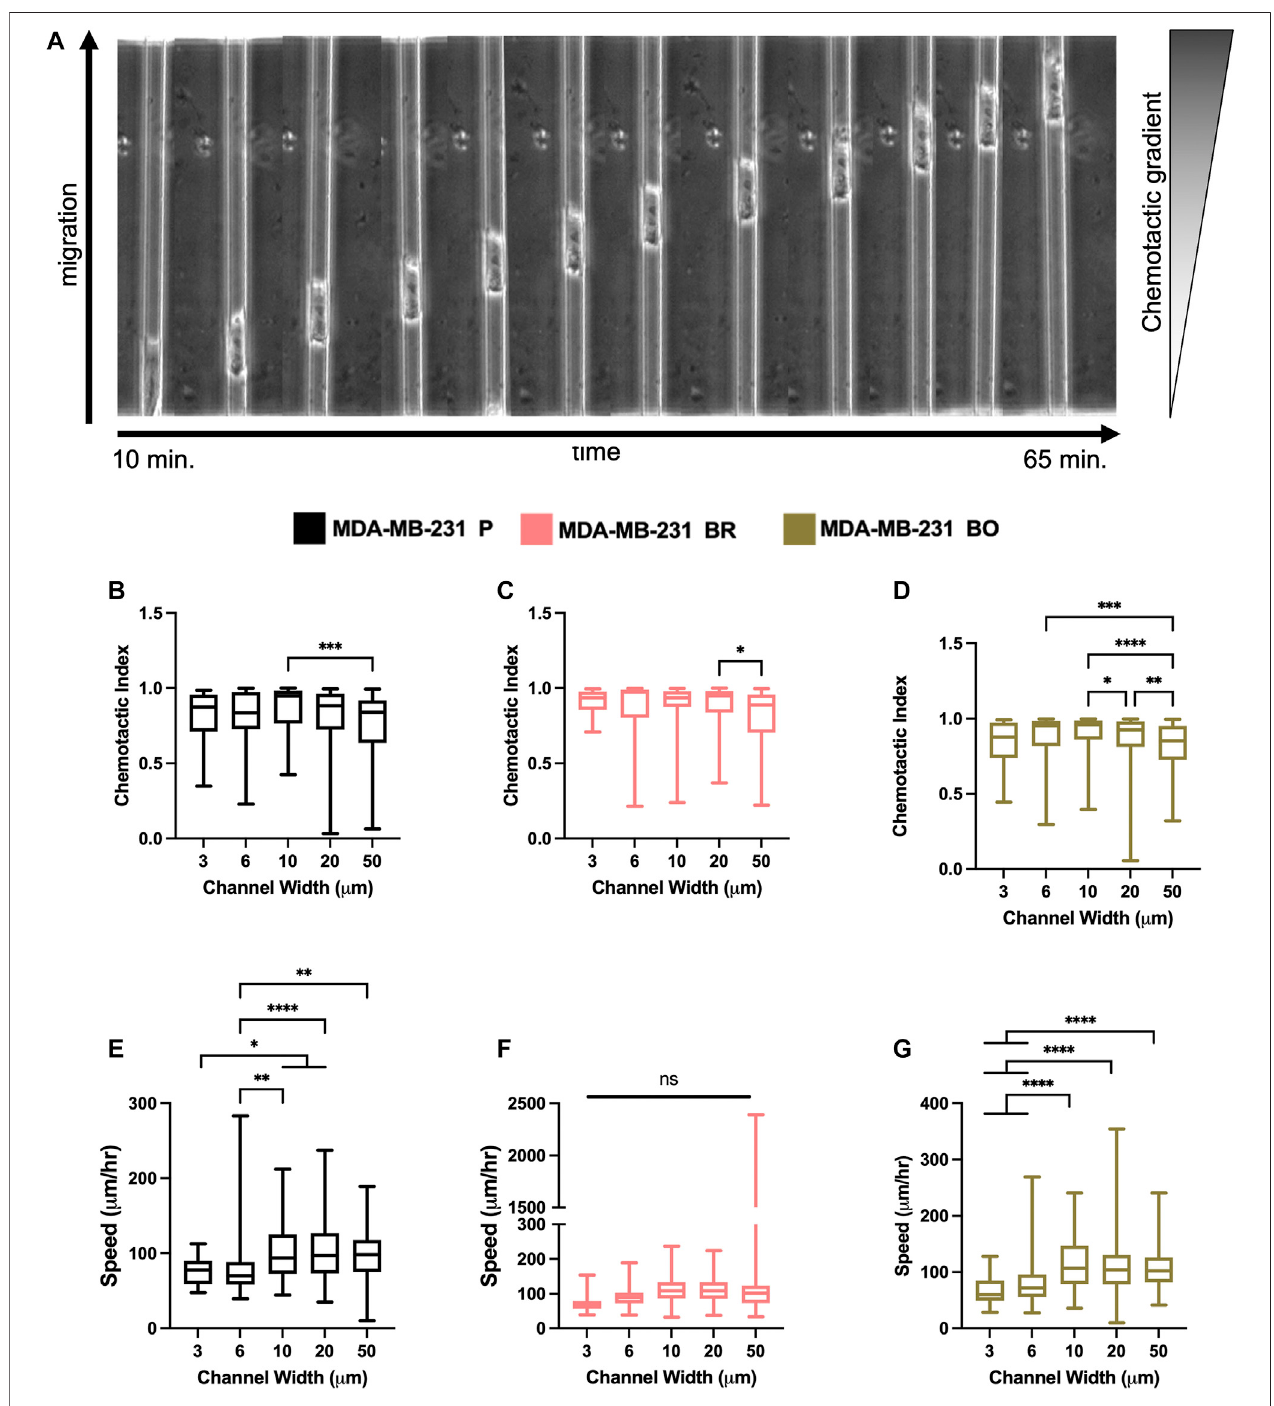
FIGURE 4 | Con fi ned migratory characteristics of organ-seeking clones (A) Phase contrast images of an MDA-P cell migrating through a 10 μ m channel. Chemotacticindiceswerequanti fi edfor (B) MDA-P, (C) MDA-BR, and (D) MDA-BO foreach channel width. Images weretakenat 5-minintervals over 12 h.Speedwas quanti fi ed for (E) MDA-P, (F) MDA-BR, and (G) MDA-BO for each channel width for over 12 h and at 5-min intervals. Box and whisker plots represent the minimum and maximum data points, the median, and the interquartile range. * indicates p < 0.05. ** indicates p < 0.01. *** indicates p < 0.001. **** indicates p < 0.0001. Each column of data is from N > 190 cells pooled from at least 3 independent experiments. The data were tested for normality using the D ’ Agostino and Pearson test and found to be normally distributed. A one-way ANOVA and multiple comparisons test were performed to determine signi fi cance these data.